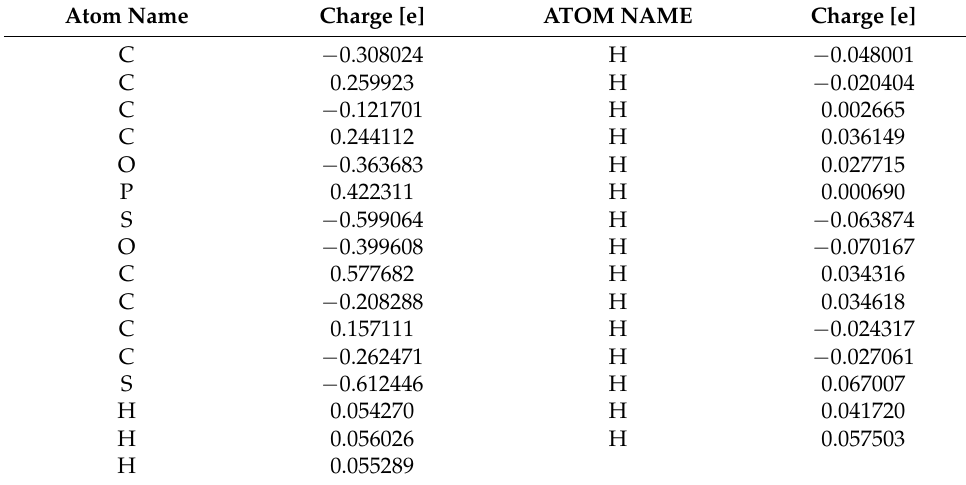
Table 3. Gaussian calculated charge parameters for the DTP anion.